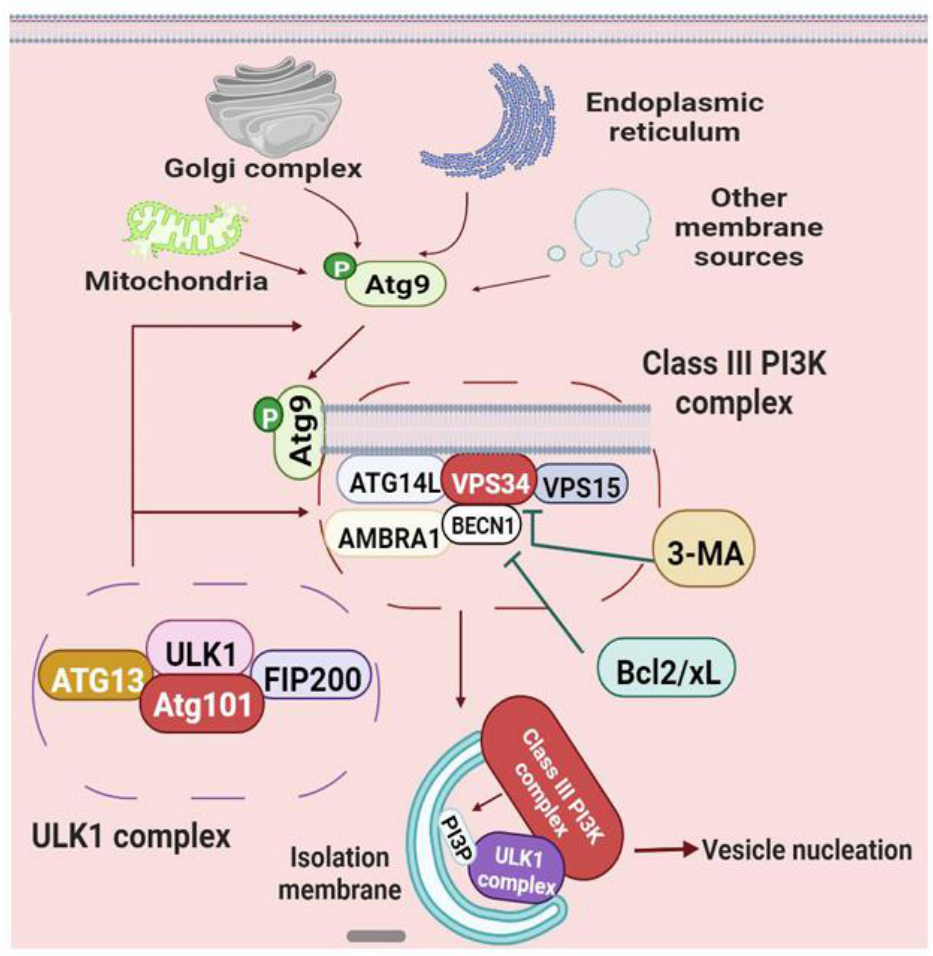
Figure 4. Schematic diagram of vesicle nucleation in macroautophagy. Vesicle expansion is orchestrated by Atg proteins and complexes, such as the class III PI3K complex. Abbreviations: 3-MA, 3-methyl adenine.